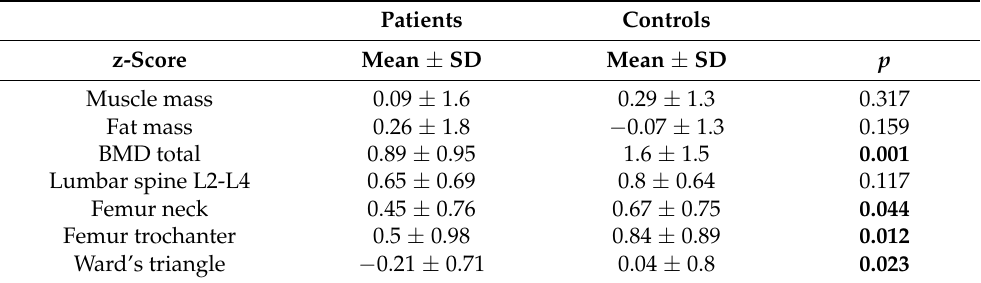
Table 5. Mean body composition z-scores as measured by DEXA in patients and controls.